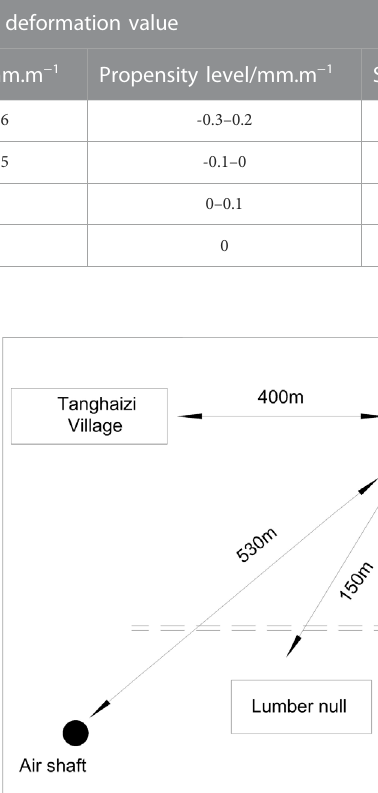
FIGURE 12 Horizontal position relationship between the fi lling face and surface